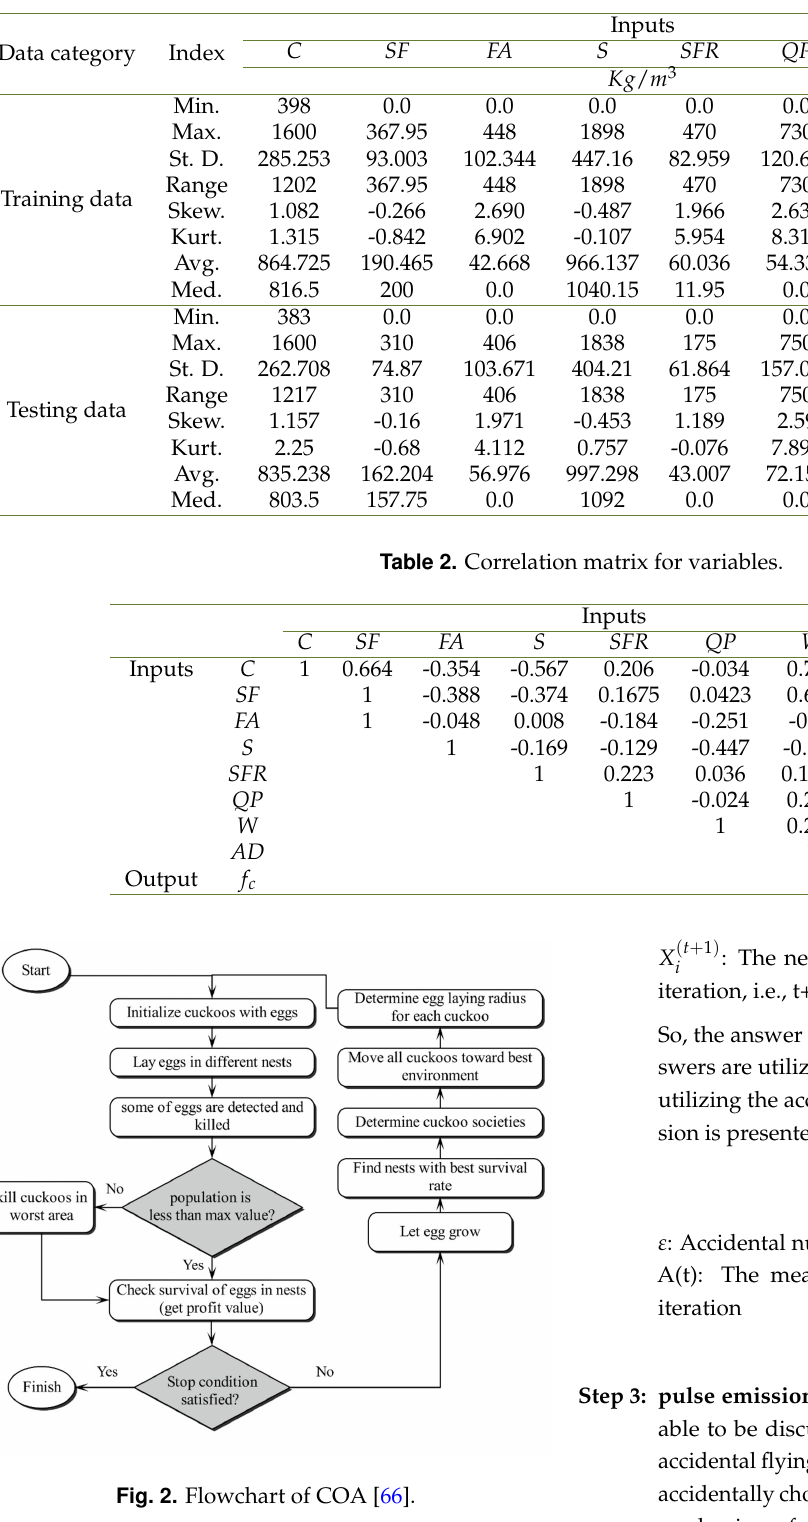
Table 1. Descriptive statistics of variables applied to models.